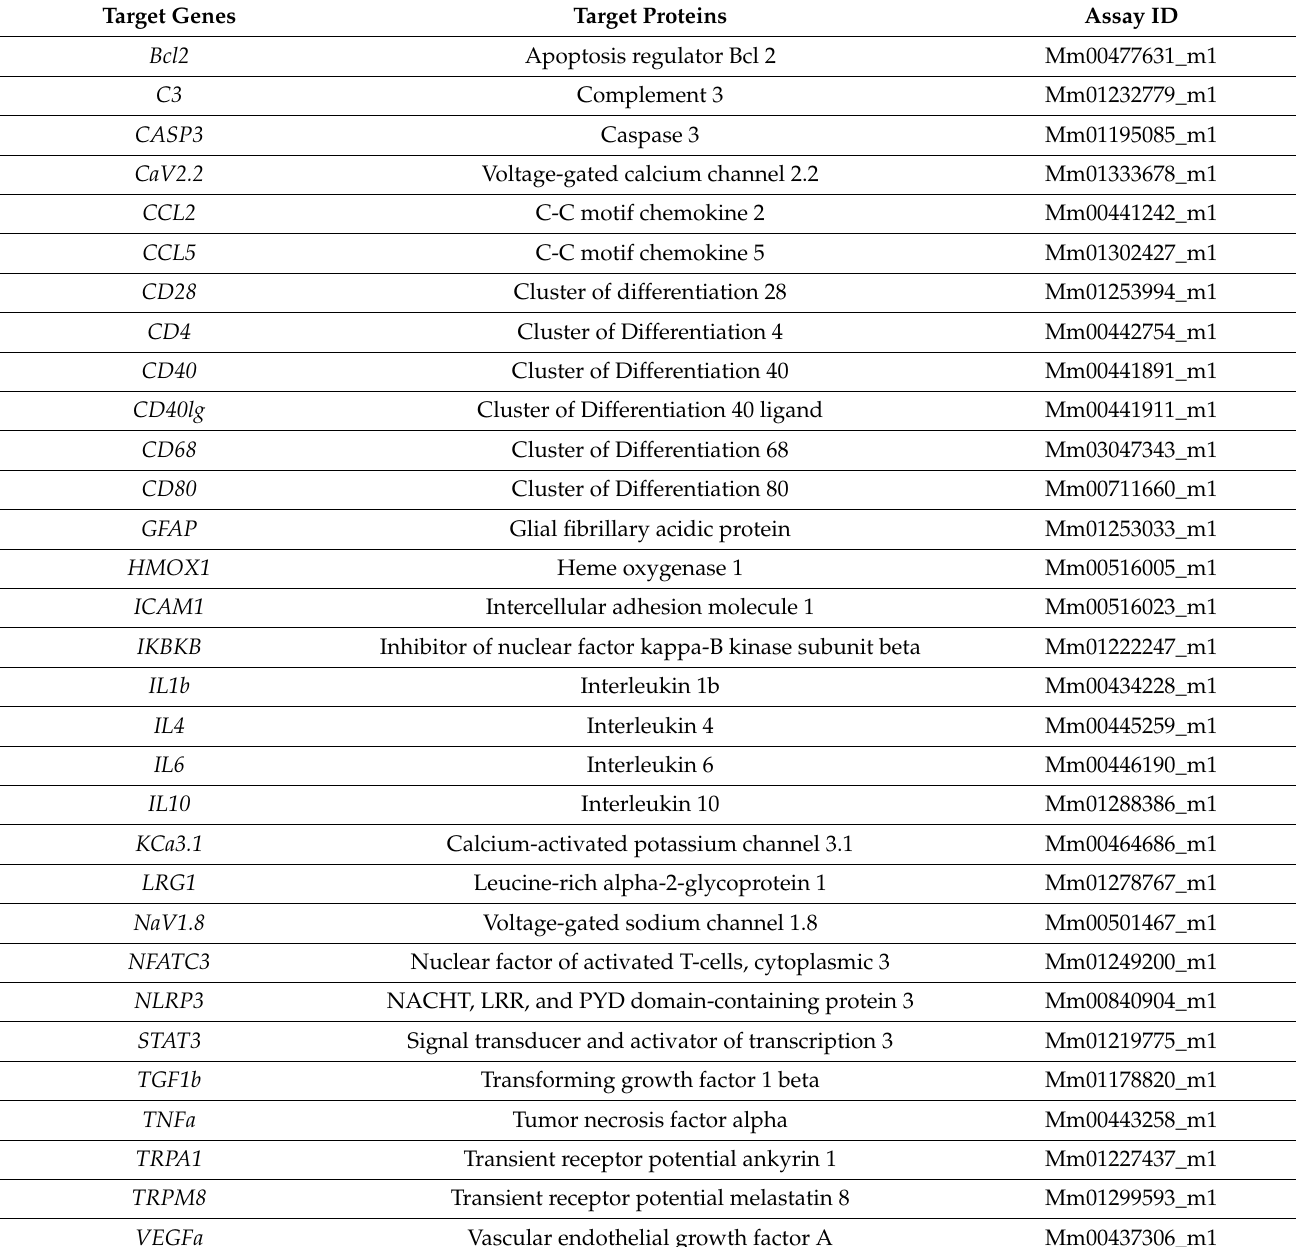
Table 1. Used gene expression assays for single qRT PCR validation. Table includes inflammation- associated genes and ion